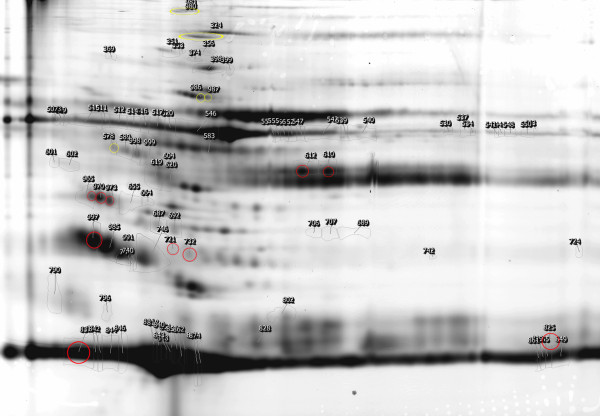
 Differentially expressed protein spots identified by DIGE analysis. Proteins were extracted as described and separated in pH 3–10 IPG strips for the first dimension and 10% polyacrylamide for the second dimension. The image was acquired on a Typhoon 9400 scanner at 633/670-nm excitation/emission wavelengths. Spots detected by the analysis software are indicated. Ten protein spot-features were found to be significantly up-regulated (red) after the ω-3 PUFAs supplementation and six were significantly down-regulated (blue) in Lp-AI of smoker participants.